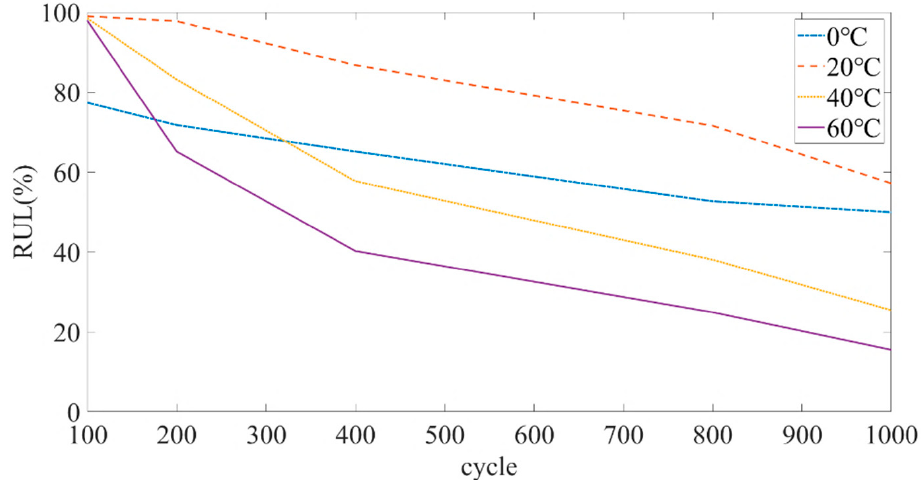
Figure 10. Degradation rate at different